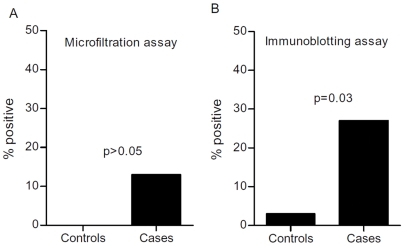
Immunoblotting may have a better positive predictive value than microfiltration assays.Panel A and B show the percentage of cases and controls that were considered positive by microfiltration or immunoblotting assay, respectively, with cutoffs established as the mean plus two standard deviations of the control values. The p-value was calculated using the Fisher's Exact Test.